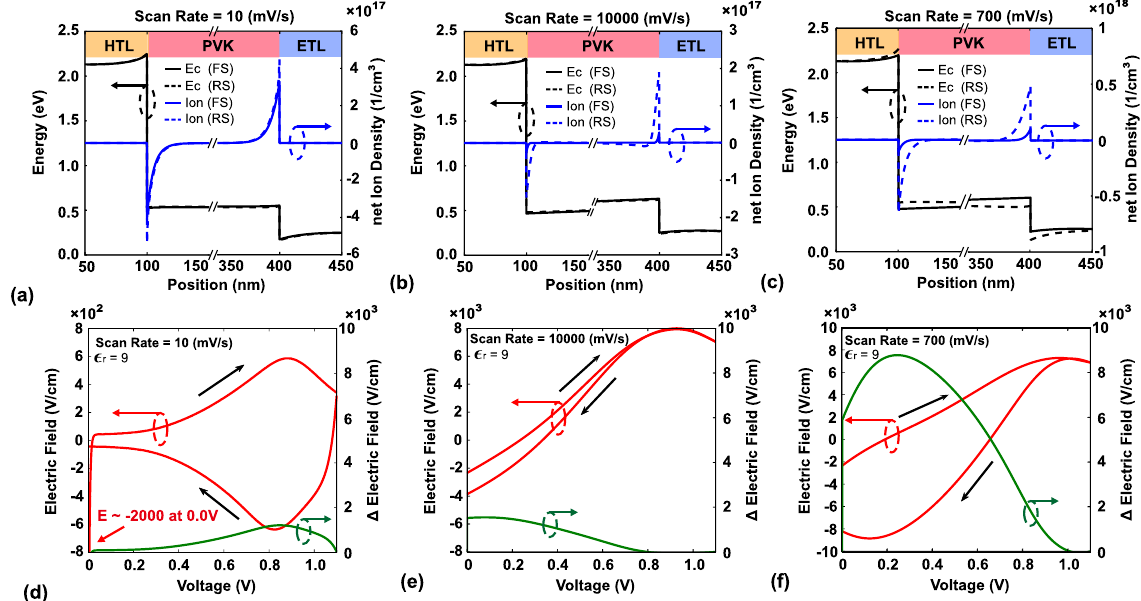
Figure 3. ( a – c ) Conduction bands and net ion density distributions at the voltage of 0.6 V for scan rates of 10, 10 4 , and 700 mV/s, respectively. ( d – f ) Electric field and change in electric field as functions of bias voltage for scan rates of 10, 10 4 , and 700 mV/s, respectively. To simplify the discussion, the electric field in this figure is the electric field at the central point of the active